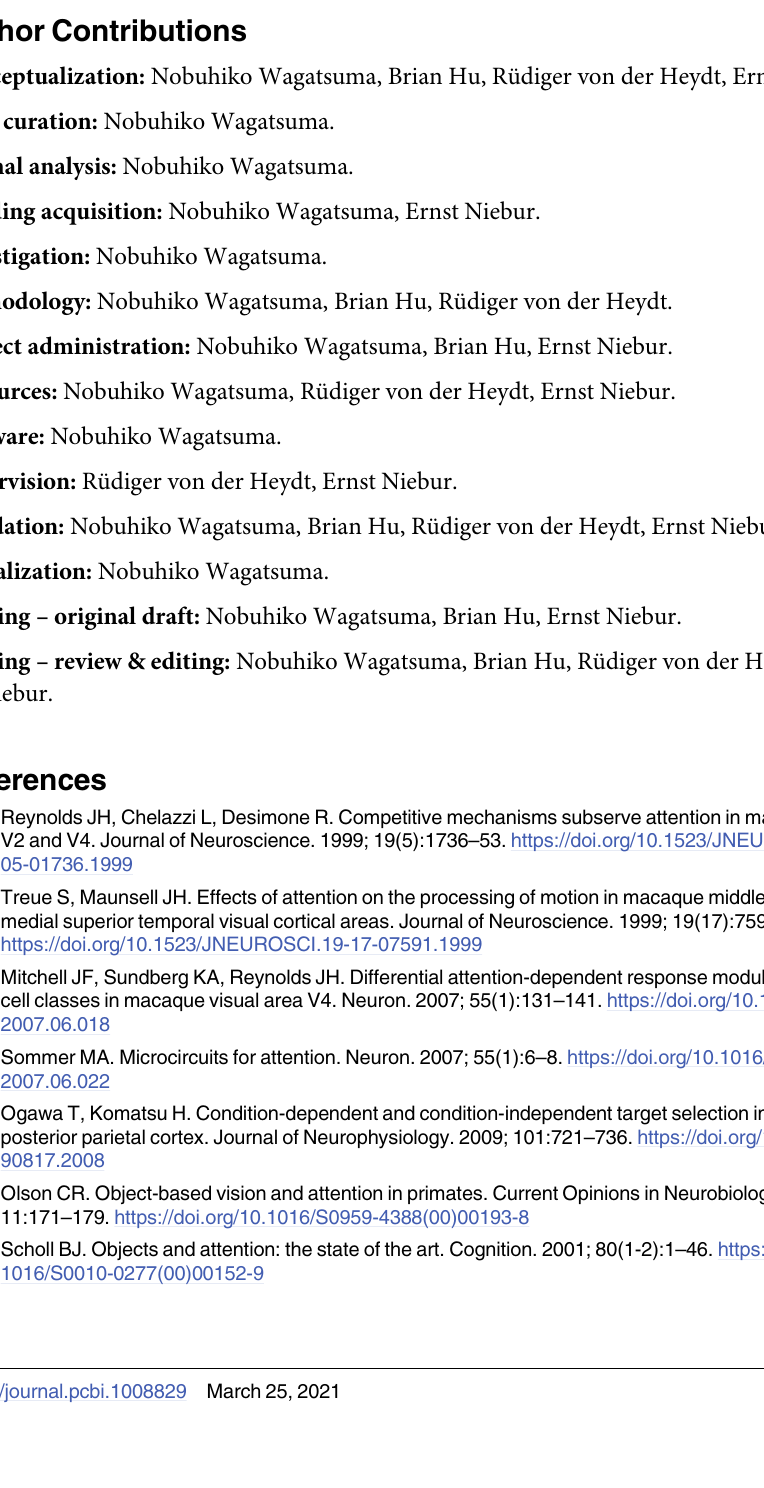
SEM. Error bars in panels B, D, and F indicate SDs. (TIF) S1 Code. The source code for the proposed model (C programming